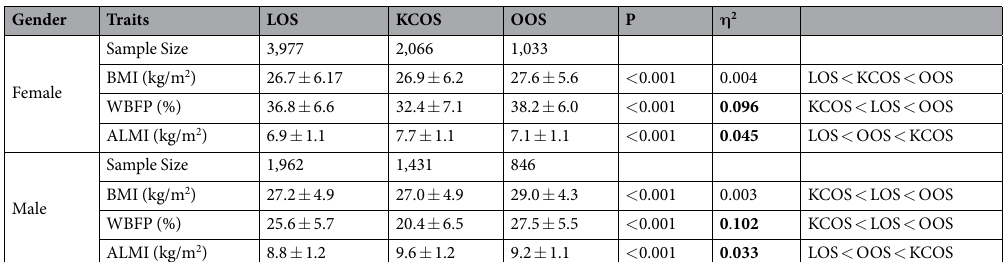
Table 3. Body composition of subjects from LOS, KCOS and OOS (mean ± SD). Note: η 2 is eta-squared effect size of ANOVA. In the study, we consider an effect size bigger than 0.01 as